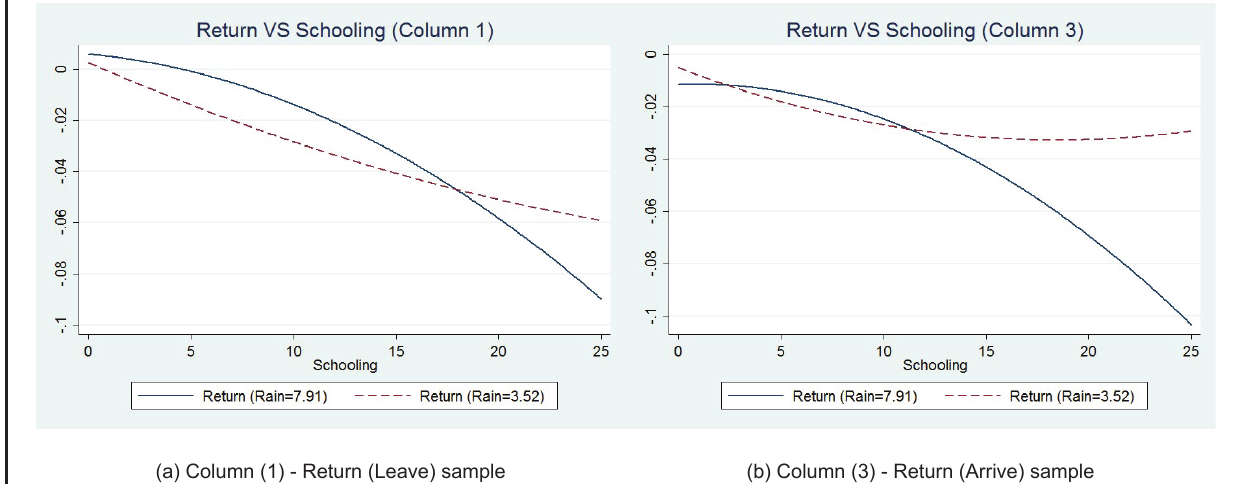
Setting the values of all control variables to zero and ignoring the constant terms, these figures show the expected or predicted return probabilities versus individuals’ years of schooling based on coefficients in Table 6. Facing droughts, migrants with some years of schooling lower their return probabilities, while the least educated migrants and the most educated migrants increase their probabilities of return to